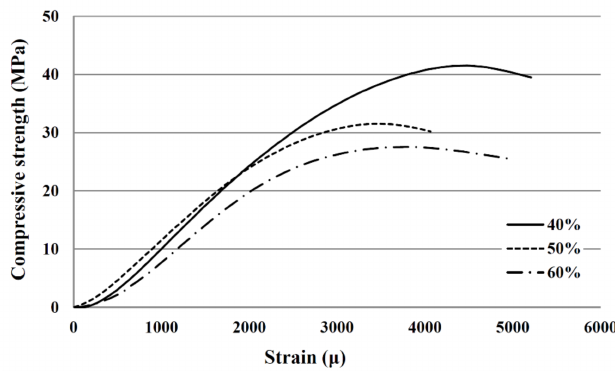
Figure 4. Stress–strain curve for normal concrete. (2)